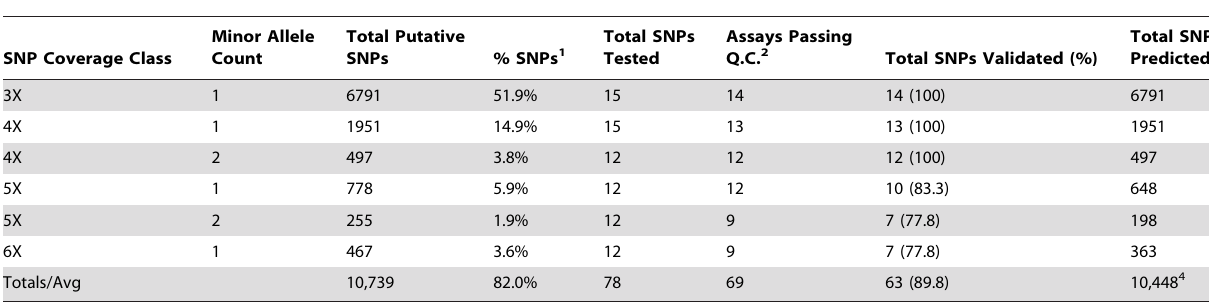
Table 1. Summary data for a white-tailed deer RRL plus RSL SNP validation